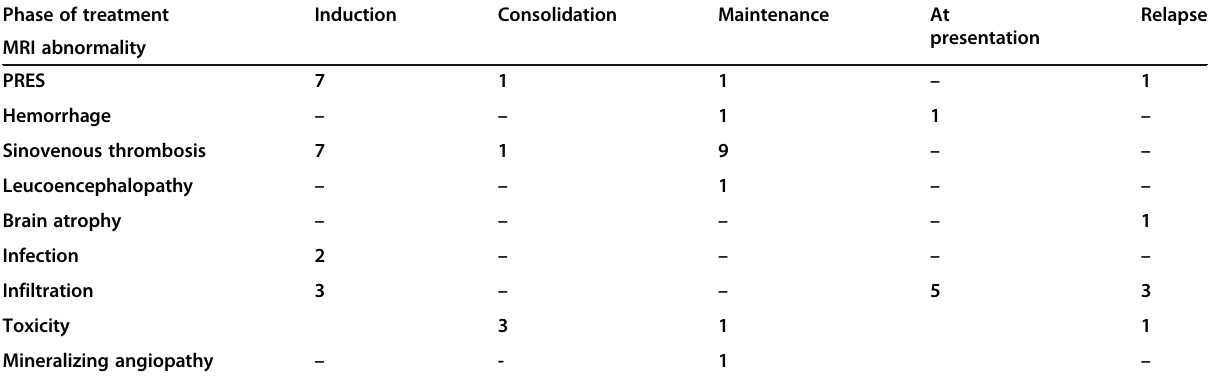
Table 2 Frequency of the MRI diagnoses within the phases of presentation Phase of treatment